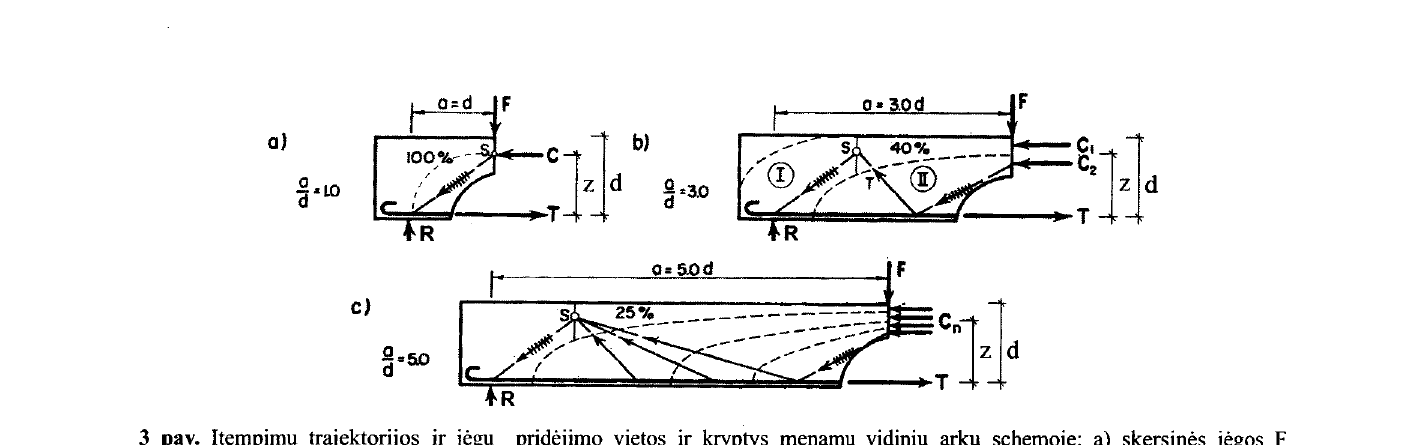
Fig 3. Stress trajectories and location of static forces and their directions in the scheme of imaginary internal arch supports: a) magnitude of distance between vertical force F and support R - Jxd; b) also 3xd; c) also 5xd